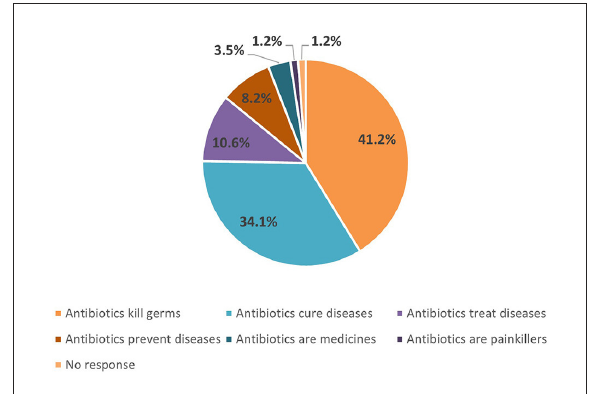
FIGURE3 The various definitions of antibiotics given by milk vendors who agreed to know about antibiotics in Haryana and Assam, India.